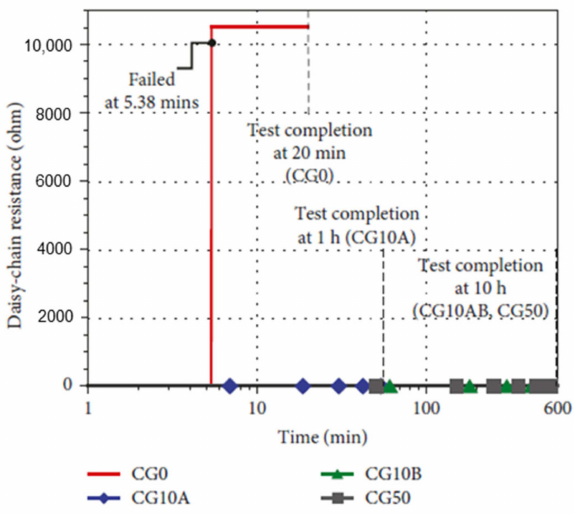
Figure 16. Random vibration fatigue test setup [10].